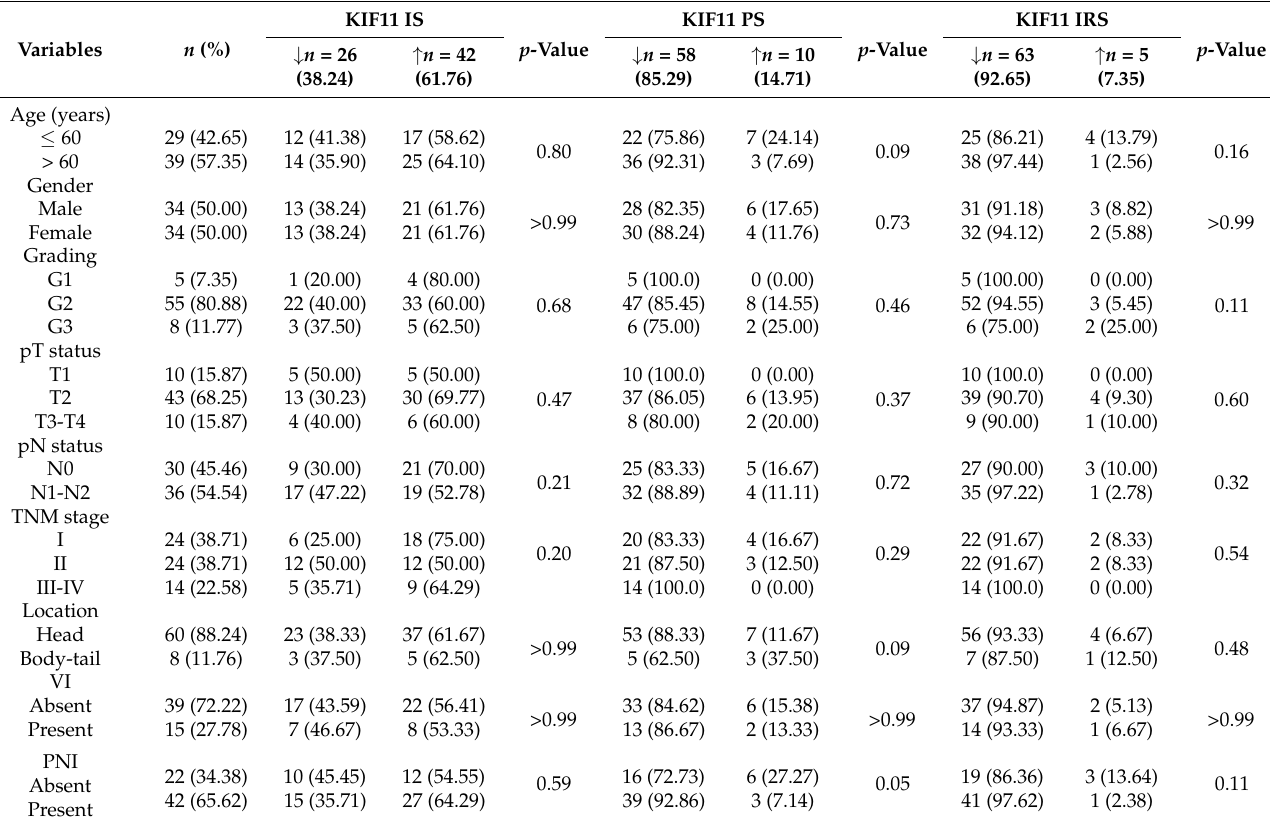
Table 1. Characteristics of the study population by KIF11 immunoexpression groups.